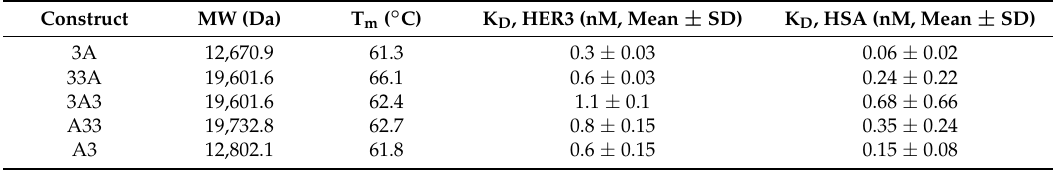
Table 1. Biophysical characteristics of different ABD-fused anti-HER3 affibody constructs. HSA: human serum albumin; T m : melting temperature; K D : equilibrium dissociation